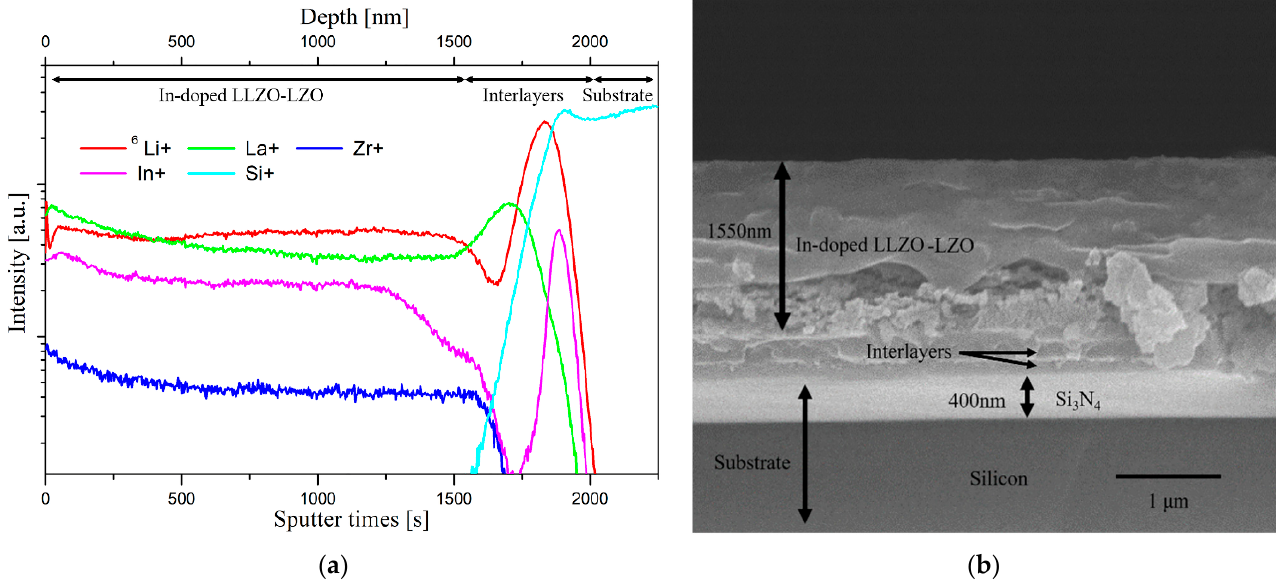
Figure 2. ( a ) TOF-SIMS depth profiles of the sample #600-IL: Si + (wathet blue), In + (purple), 6 Ll + (red), La + (green), and Zr + (dark blue); ( b ) the cross-section microstructure of the prepared sample #600-IL.